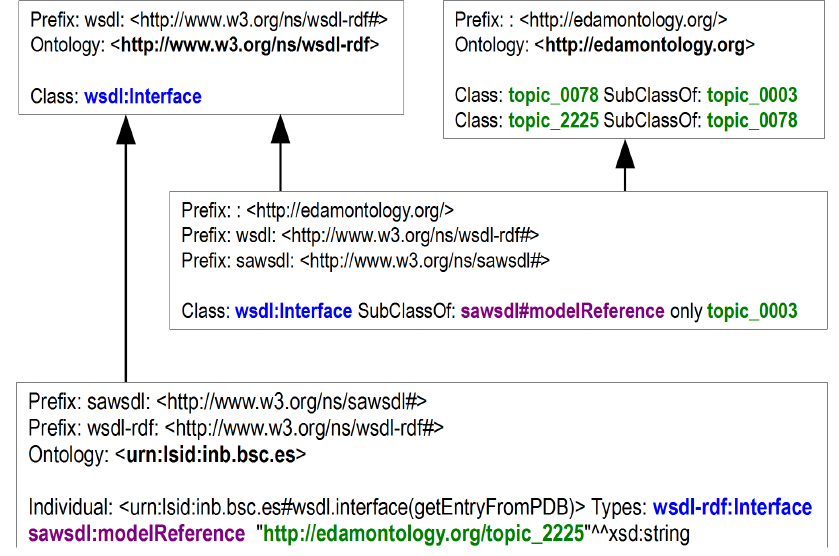
Figure 4. Example of Semantic Rules definitions. Here wsdl: Interface sawsdl # modelReference property is restricted to topic_ 0003 (Topic). Because topic_ 2225 (Protein databases) is a subclass of topic_ 0003, urn:lsid:inb.bsc.es # wsdl.interface(getEntryfromPDB) interface (which is an individual of wsdl: Interface) may be annotated with it without making the ontology inconsistent.